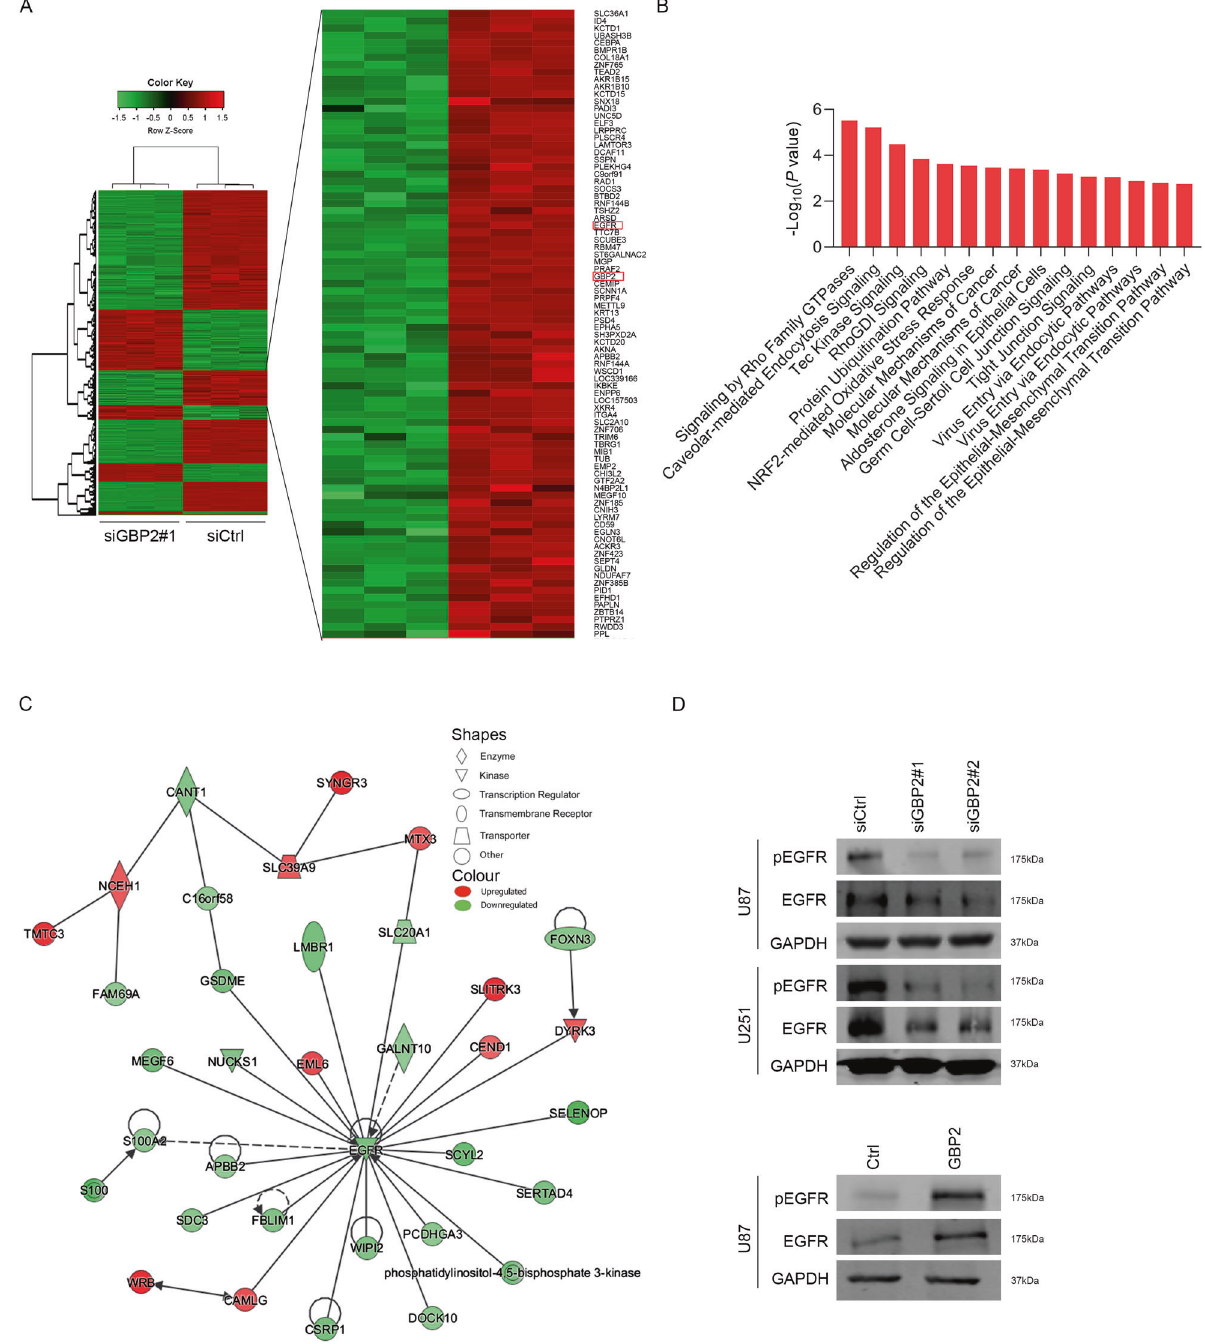
Fig. 4 GBP2 regulates EGFR signaling pathway. A Heat map showing distinct level of mRNAs in control and siGBP2 cells. In the clustering analysis, red indicates upregulated genes, green indicates downregulated genes, and gray dots represent genes showing no change in expression. B The pathway enrichment analysis using IPA analysis with GBP2 knockdown according to microarray datasets. C IPA analysis of biological protein interactions with GBP2 involved in EGFR signaling pathway according to microarray datasets. D Western blotting results showing changes in protein levels in the EGFR signaling pathway. U87 cells with GBP2 overexpression or depletion are